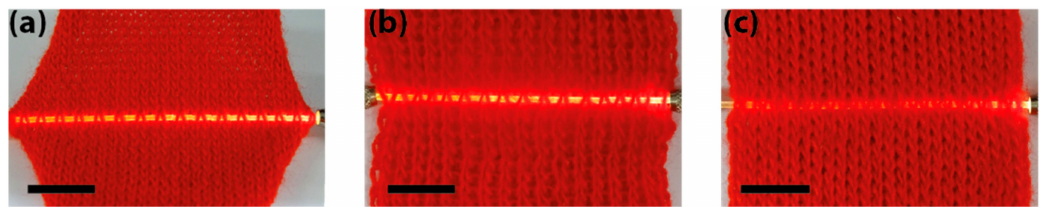
Figure 6. Pictures of the knitted fabrics: ( a ) single jersey; ( b ) 1 × 1 rib; and ( c ) 1 × 1 interlock fabrics. The scale bar indicates 10